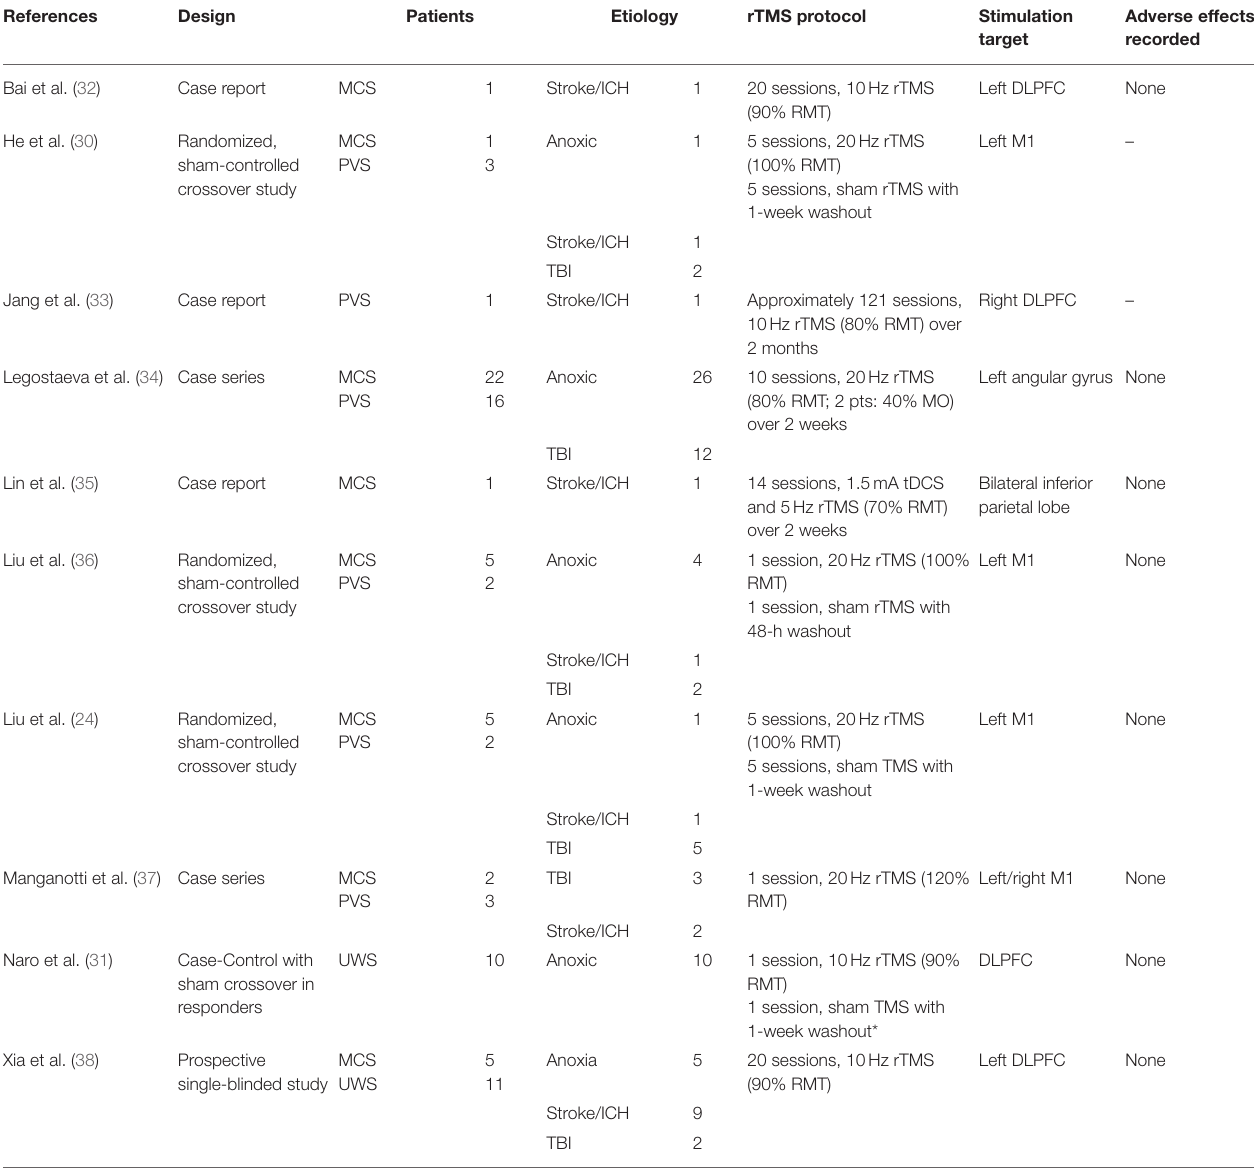
TABLE 1 | Overview of included studies.